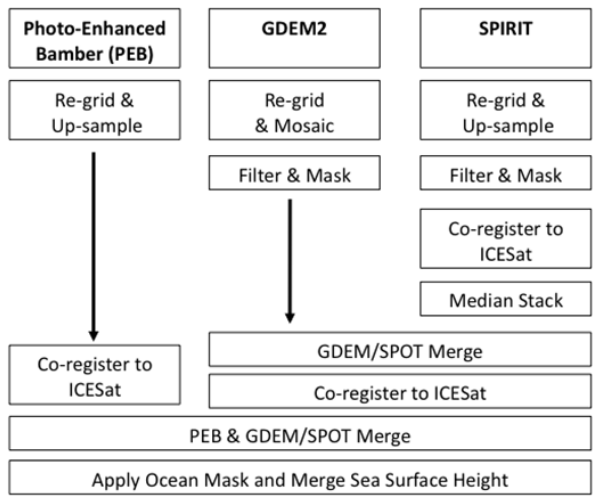
Figure 3. Schematic of the approach used to the produce the GIMP DEM from the three source data